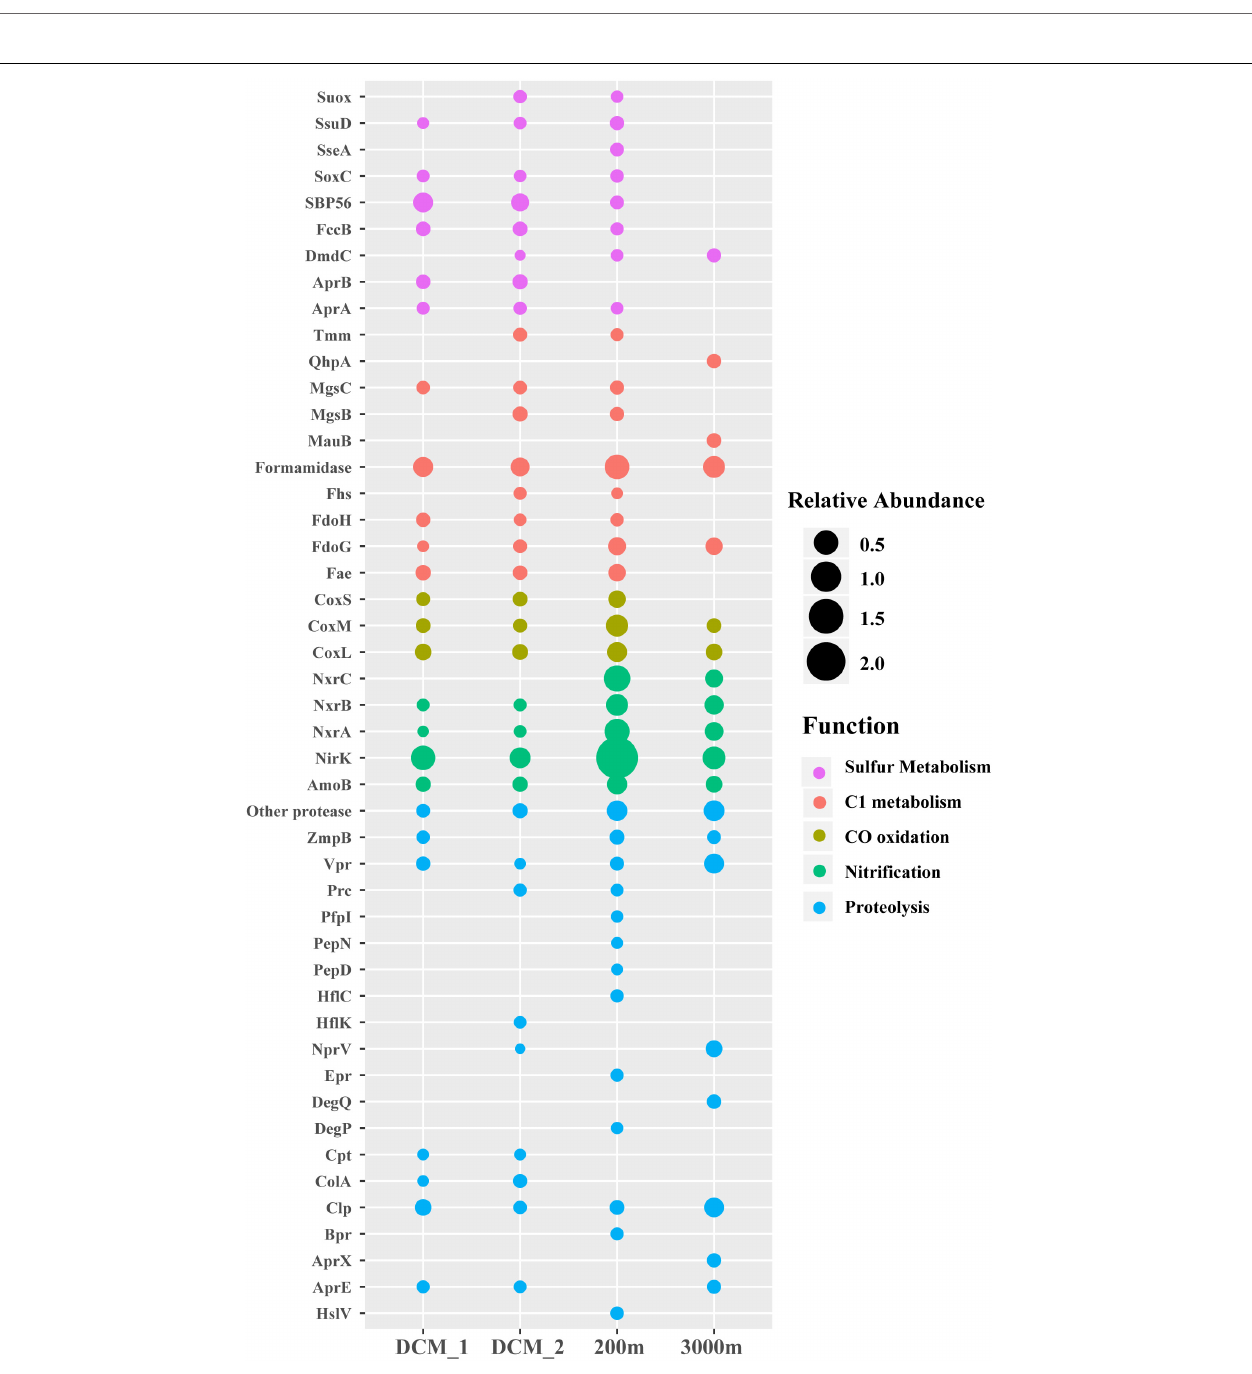
Frontiers in Microbiology |